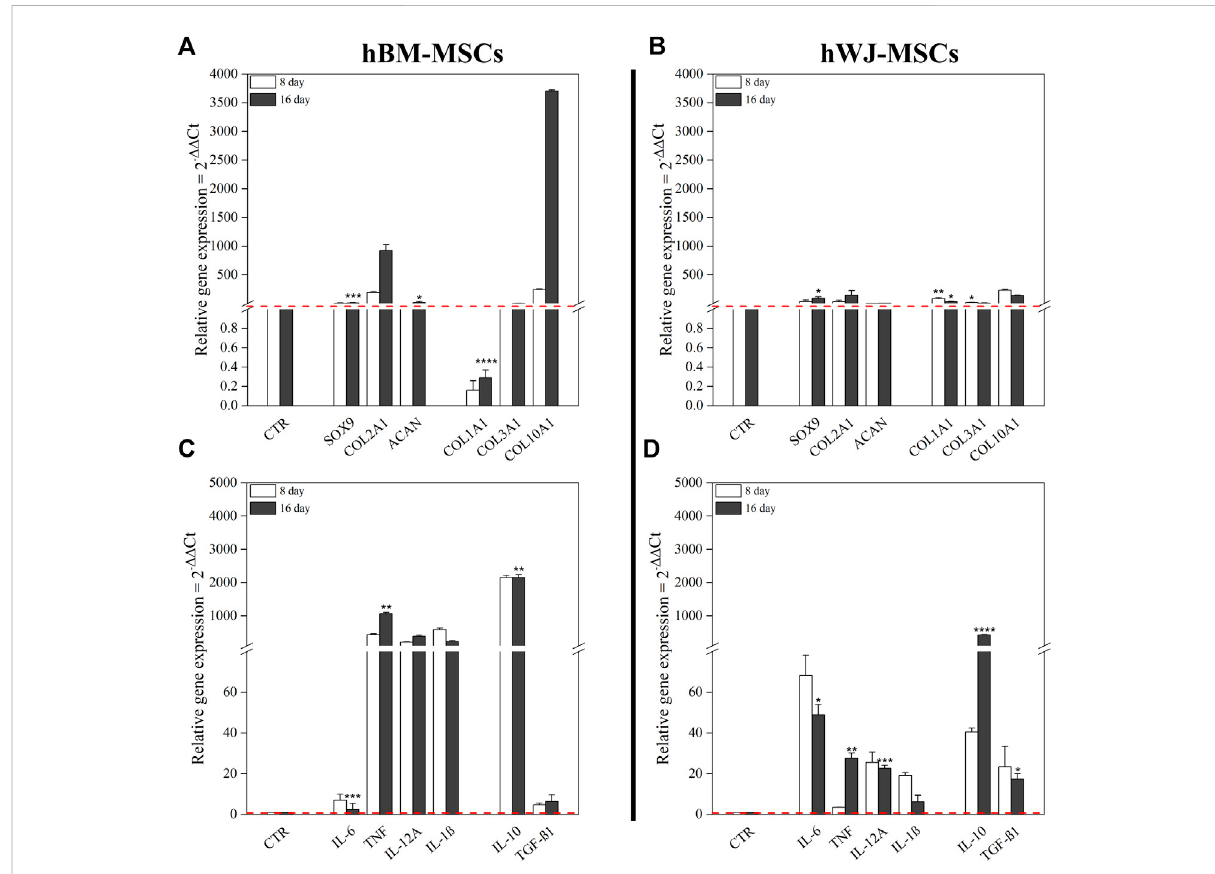
FIGURE 4 Gene expression pro fi les of both hBM-MSCs and hWJ-MSCs based high density culture supplemented with 10 ng/ml of hTGF- β 1. mRNA expression levels of positive and negative chondrogenic markers ( COL1A1 , COL2A1 , COL3A1 , COL10A1, SOX9 , and ACAN ) (A,B) and cytokines ( IL-6